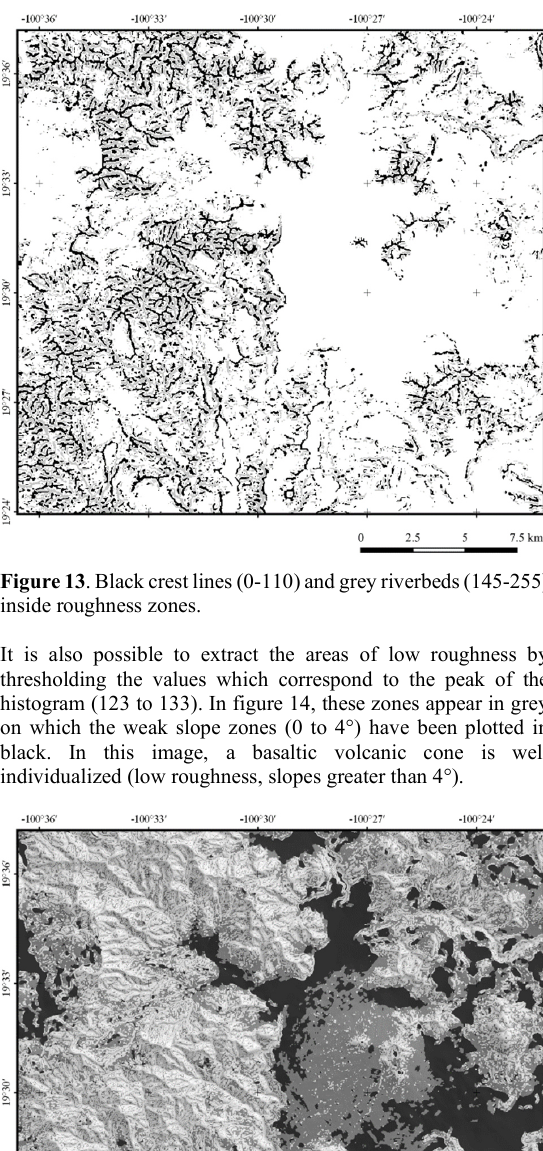
Figure 11 . Edges of the riverbed and terrace borders.